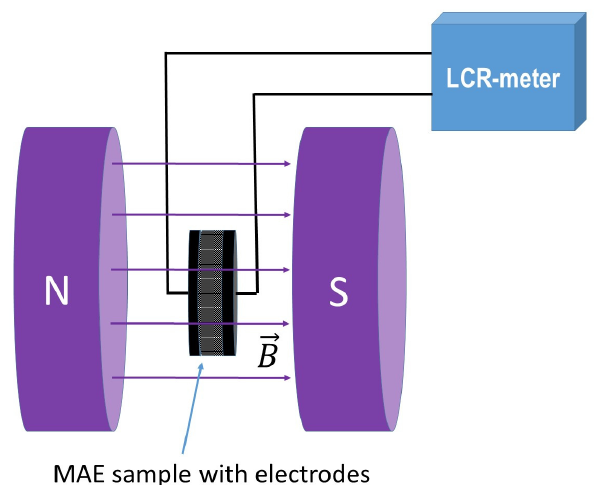
Figure 1. A schematic of a setup for studying the effect of a magnetic field on the dielectric permittivity of MAEs.